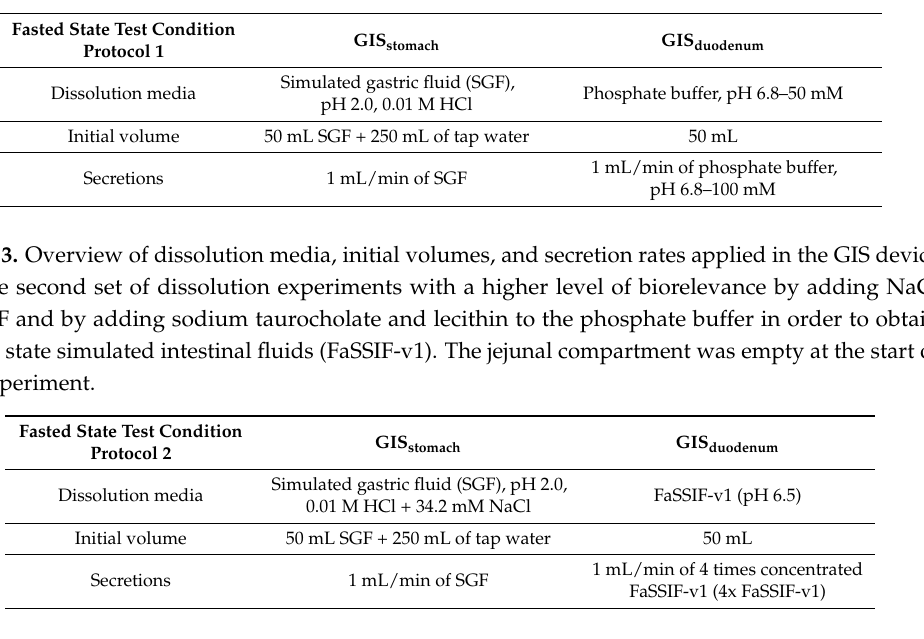
Table 2. Overview of dissolution media, initial volumes, and secretion rates applied in the gastrointestinal simulator (GIS) device for the first set of standard dissolution experiments (i.e., standard dissolution settings). The jejunal compartment was empty at the start of the experiment.